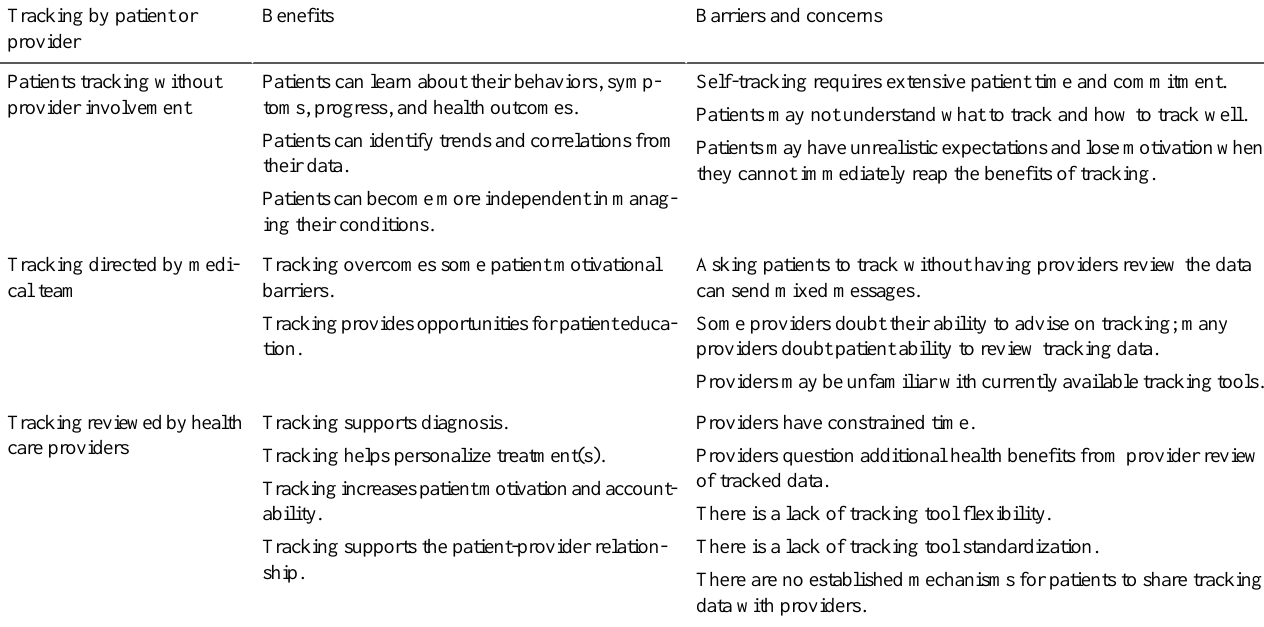
Table 2. Summary of results showing provider attitudes about benefits and barriers of self-tracking and reviewing tracked